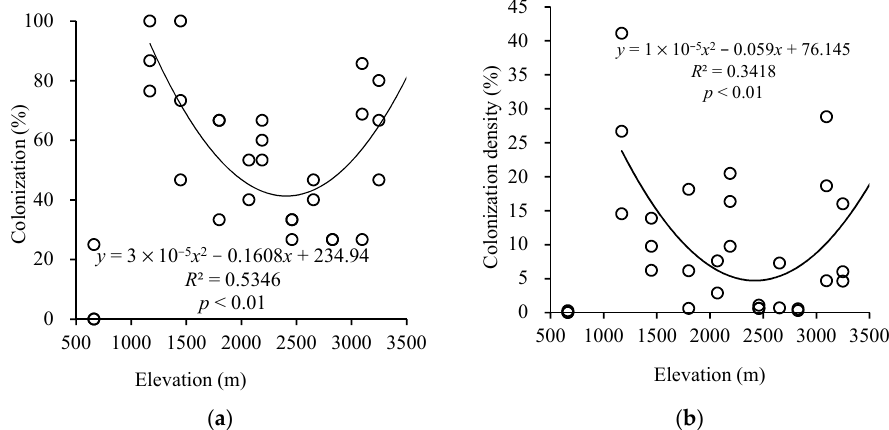
Figure 1. Change of arbuscular mycorrhizal colonization ( a ) and colonization density ( b ) in plant roots among different altitudes. Note: There are overlapping data points in ( a , b ).